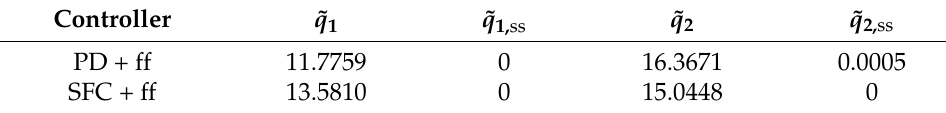
Table 2. RMS comparative of the simulation results for ˜ q without F C